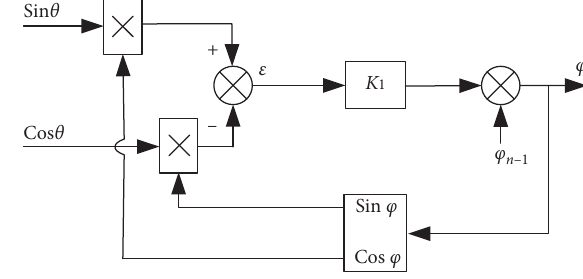
Figure 2: ATO schematic